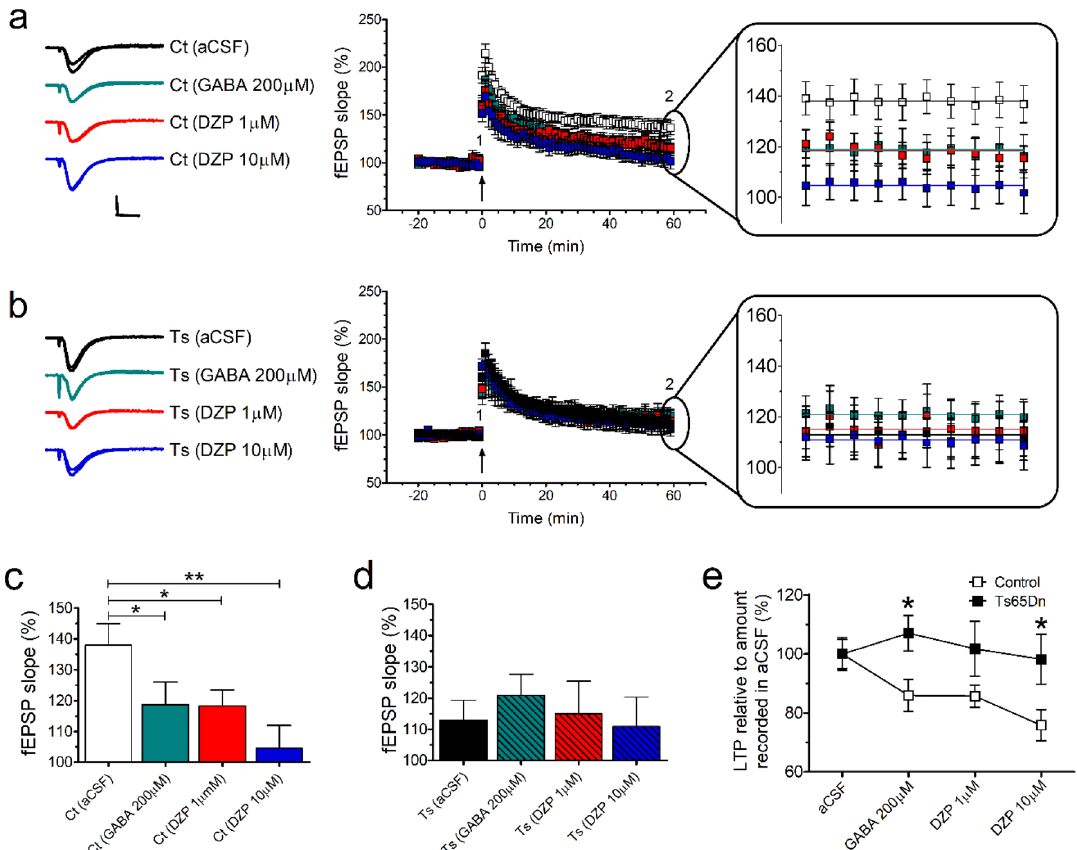
Figure 5. The magnitude of CA1 TBS-induced LTP is depressed by GABA and diazepam in control- but not in Ts65Dn-derived slices. ( a , b ) The calculated mean fEPSP slopes of TBS-induced LTP for control- ( a ) and Ts65Dn- ( b ) derived slices. Arrow indicates LTP induction, and representative traces show synaptic response during baseline (time 1) and at end of recording (time 2). The magnification of the last 10 min of recording is also shown. Scale bars represent 1 mV (horizontal) and 10 ms (vertical). ( c , d ) Summary graph of the LTP data from control- ( c ) and Ts65D- ( d ) derived slices (mean fEPSP slope during the last 10 min of recording). Both GABA and diazepam reduced the mean level of TBS-induced LTP in control-derived slices, whereas neither GABA nor diazepam affected the mean level of TBS-induced LTP in Ts65Dn-derived slices. ( e ) Normalized data show a greater effect of inhibition on LTP in control slices at 200 μM GABA and 10 μM diazepam than in those derived from 48 Ts65Dn mice. Number of slices (one slice per mouse for each condition): Ct aCSF (N = 12), Ct 200 μM GABA (N = 12), Ct 1 μM diazepam (N = 12), Ct 10 μM diazepam (N = 12), Ts aCSF (N = 12), Ts 200 μM GABA (N = 12), Ts 1 μM diazepam (N = 12), and Ts 10 μM diazepam (N = 12). Data represent mean ± SEM. Statistical significance is expressed as * and ** for P < 0.05 and P < 0.01, areas of the EPM, which is supported by the significant increase in the number of open arm entries and time spent in open arms without affecting the number of closed arm entries and time spent in closed arms. However, Ts65Dn mice treated with diazepam did not differentiate between areas of the EPM. We then scored ethological patterns of response as a means to assess behavioral strategies (i.e. risk assess- ment behaviors) expressed by mice when dealing with stressful situations. First, we assessed the frequency of stretched attend posture (SAP), which is characterized by a forward elongation of the animal’s body followed by a retraction to its original position. SAP was differentiated as protected (i.e., occurring on/from the closed arms or central platform) or unprotected (occurring on/from the open arms). Two-way ANOVA showed that treatment (F (1, 56) = 6.955, P = 0.0108), but not genotype (F (1, 56) = 0.551, P = 0.4611), had significant effects on the percentage of protected SAP [(protected/total) × 100]. A significant interaction was found between genotype and treatment (F (1, 56) = 5.104, P = 0.0278; Supplementary Table S13). Post hoc tests revealed that vehicle-treated Ts65Dn mice had significantly less protected SAP than vehicle-treated control mice ( P = 0.0383; Fig. 6e). Treatment with diazepam significantly decreased protected SAP in control mice when compared to vehicle-treated control mice ( P = 0.0007; Fig. 6e; Supplementary Table S14). Regarding the percentage of unprotected SAP [(unpro- tected/total) × 100], analysis showed that treatment (F (1, 56) = 7.253, P = 0.0093), but not genotype (F (1, 56) = 0.071, P = 0.7903), had significant effects on this parameter. No significant interaction was found between genotype and treatment (F (1, 56) = 1.721, P = 0.1949; Supplementary Table S13). Post hoc tests showed that the percentage of unprotected SAP was significantly higher for diazepam-treated control mice than for vehicle-treated control mice ( P = 0.0049; Fig. 6f; Supplementary Table S14).